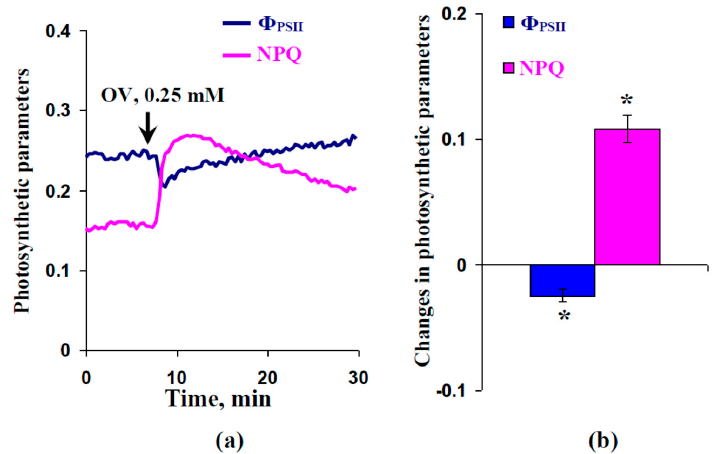
Figure 9. Example of changes in quantum yield of photosystems II ( Φ PSII ) and non-photochemical quenching of chlorophyll fluorescence (NPQ) after injection of sodium orthovanadate (OV) ( a ) and average magnitudes of these changes ( b ) in protoplasts of peas ( n = 6). OV was dissolved in standard solution (1 mM KCl, 0.5 mM CaCl 2 , and 0.1 mM NaCl); the arrows mark the OV injection into the